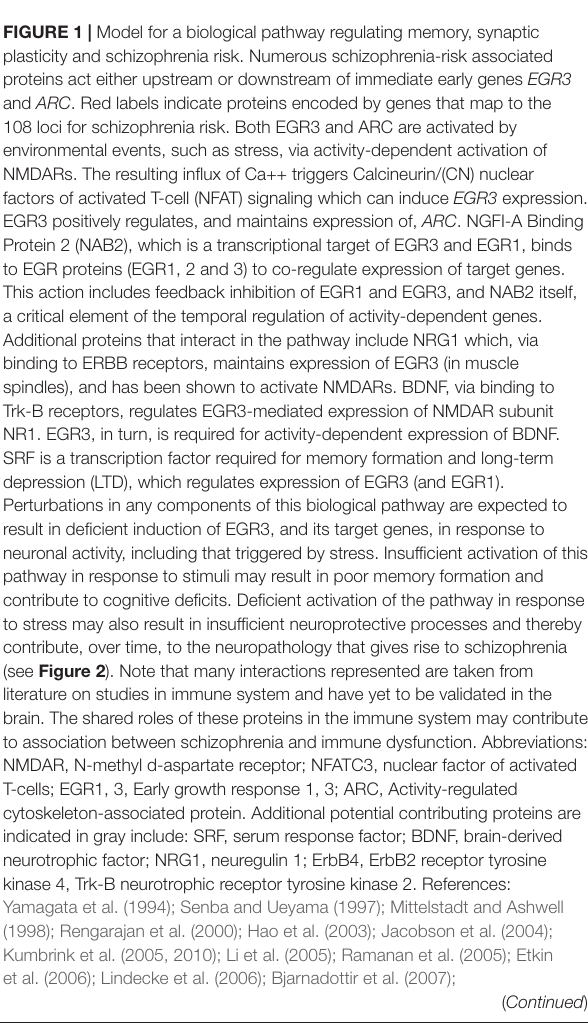
T-cells; EGR1, 3, Early growth response 1, 3; ARC, Activity-regulated cytoskeleton-associated protein. Additional potential contributing proteins are indicated in gray include: SRF, serum response factor; BDNF, brain-derived neurotrophic factor; NRG1, neuregulin 1; ErbB4, ErbB2 receptor tyrosine kinase 4, Trk-B neurotrophic receptor tyrosine kinase 2. References: Yamagata et al. (1994); Senba and Ueyama (1997); Mittelstadt and